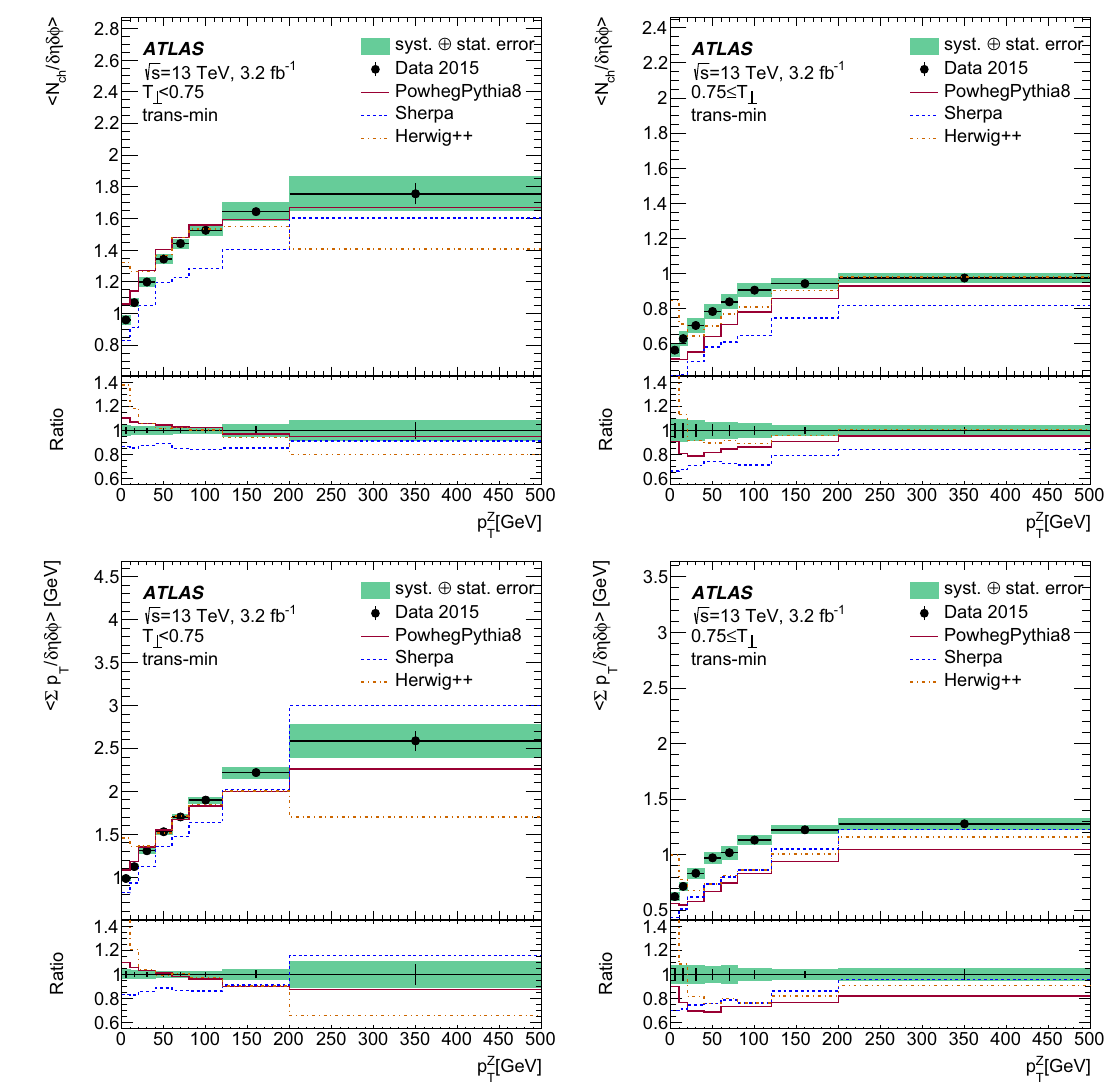
Fig. 11 Comparison of measured arithmetic means of the N ch (upper row) and (cid:8) p T (lower row) as functions of p Z (left) and 0 . 75 ≤ T ⊥ (right) for the trans-min region. Predictions of